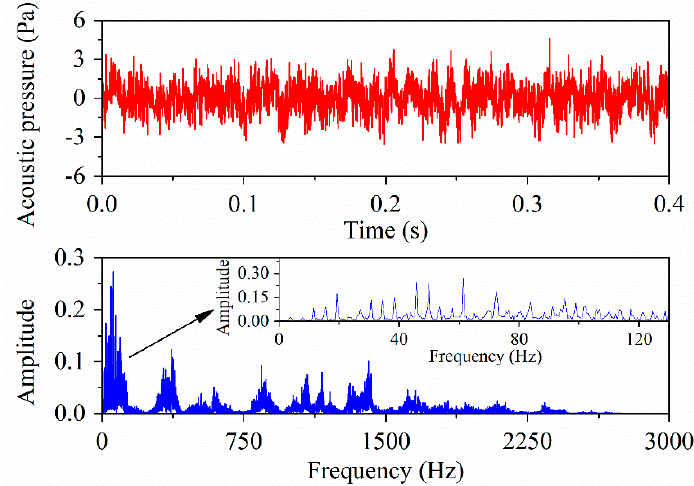
Figure 10. The time and frequency domain distributions of collected acoustic signals.